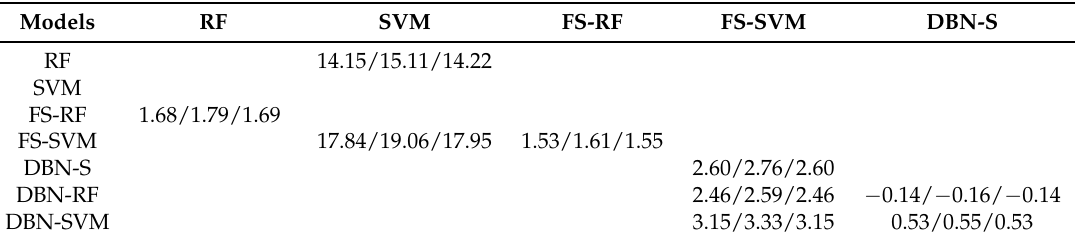
Table 8. The percentage deviation values (%) of overall accuracy, Kappa, F1-score between different models. RF: random forest. SVM: support vector machine. FS-RF: RF with feature selection